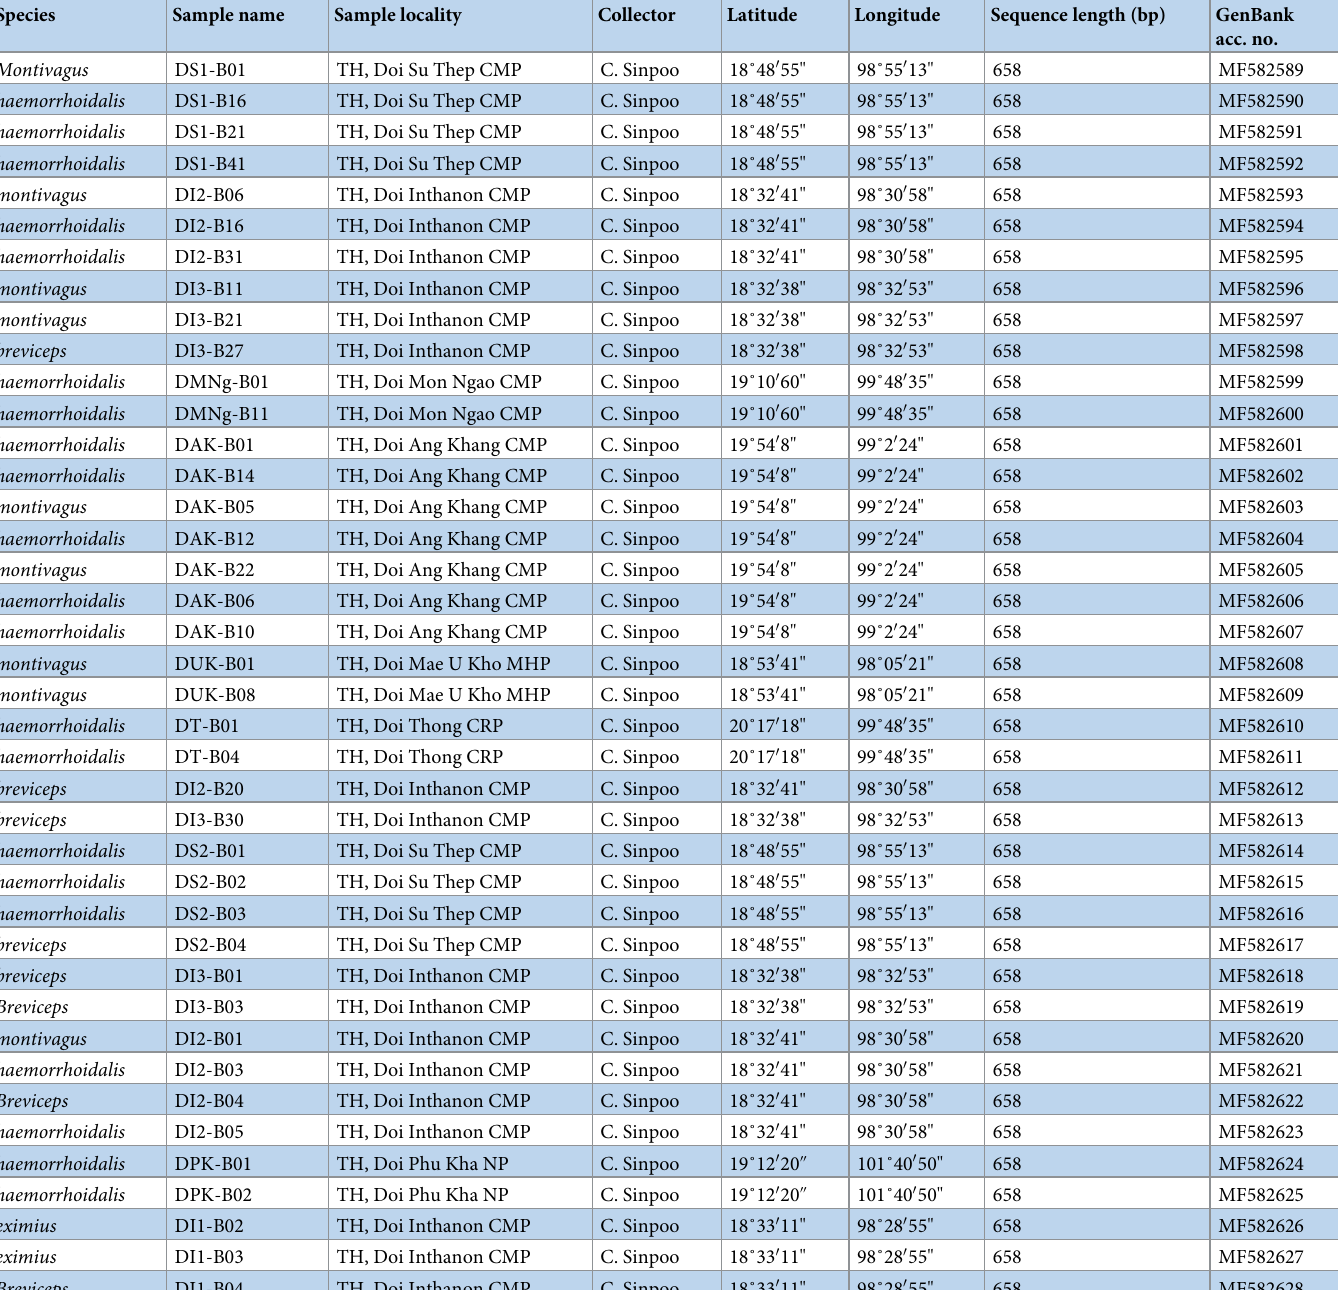
Table 4. Material used in the phylogenetic analysis with the sample localities, collector, COI sequence length, depository and GenBank accession number.